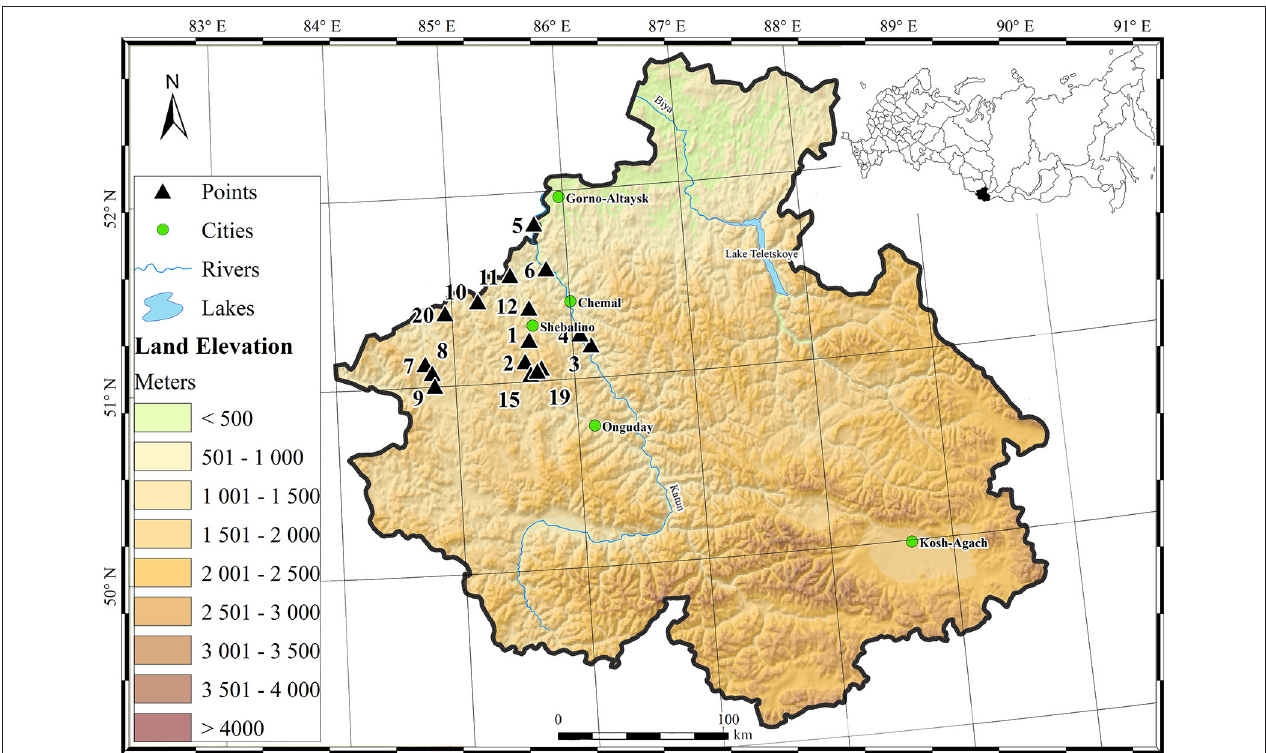
FIGURE 1 | Map of sampling sites in the Gorny Altay Republic of